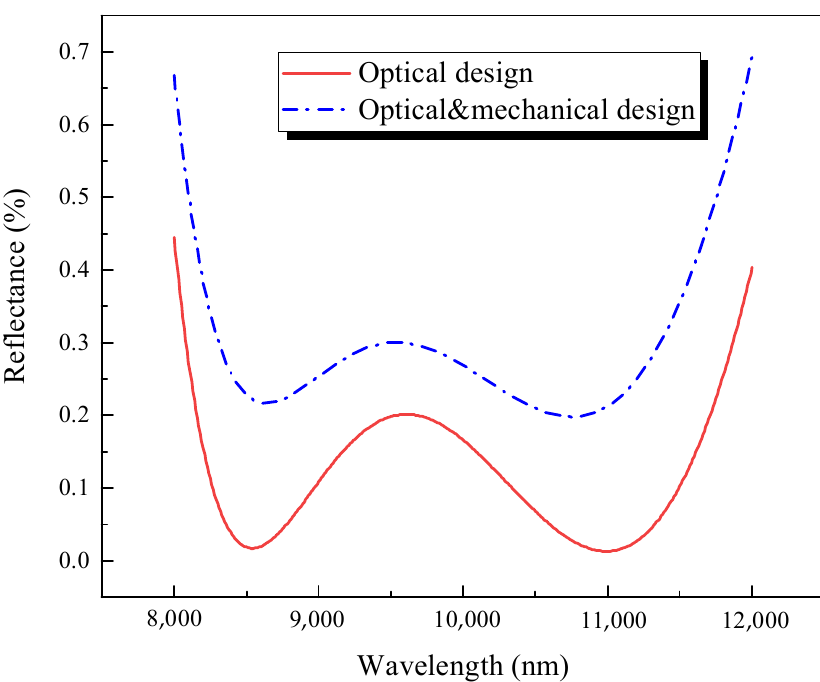
Figure 5. Theoretical spectral curve of ultra-low stress films. Based on the results of the optical-mechanical integrated design, ultra-low stress long-wave infrared anti-reflection films were prepared. The sample stress was measured with a ZYGO laser interferometer, and the value of the substrate surface shape can be directly obtained from the measurements. The peak-valley value PV can be understood as the distance from the highest point to the lowest point of the substrate surface diagram. The sagittal height Power is used to represent the overall bending direction and degree and it is a best fit value. When the substrate surface shape is excellent, PV is approximately equal to Power . Figure 6 shows the substrate surface diagram before and after coating. The PV and Power before coating are respectively: 0.253 λ , 0.234 λ . The PV and Power after coating are respectively: 0.18 λ , − 0.171 λ , where λ = 632.8 nm. The relationship between Power and curvature radius R is shown in Equation (10):